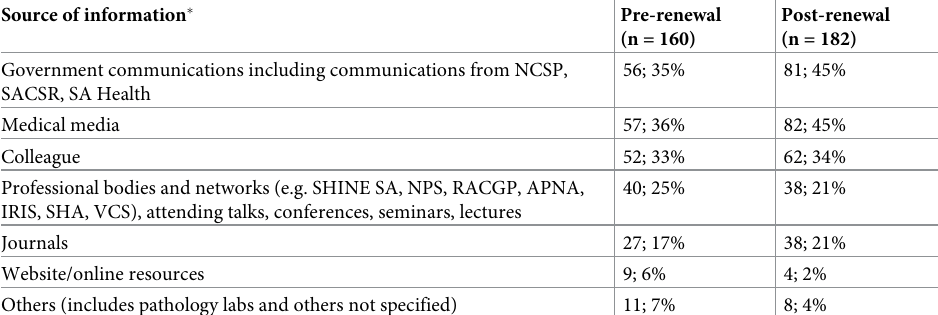
Table 6. Source of information about the changes to the National Cervical Screening Program in Australia reported by practitioners in the pre- and post-renewal samples. Source of information � Pre-renewal